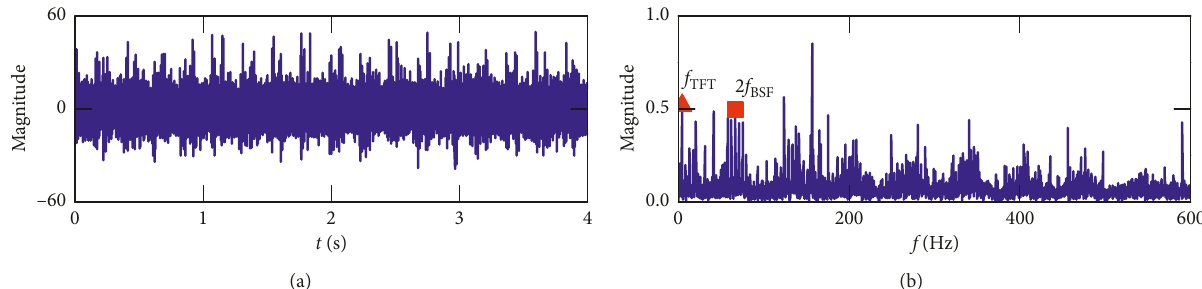
Figure 14: Bearing roller fault signal and squared envelope spectrum: (a) time-domain waveform; (b) squared envelope spectrum.